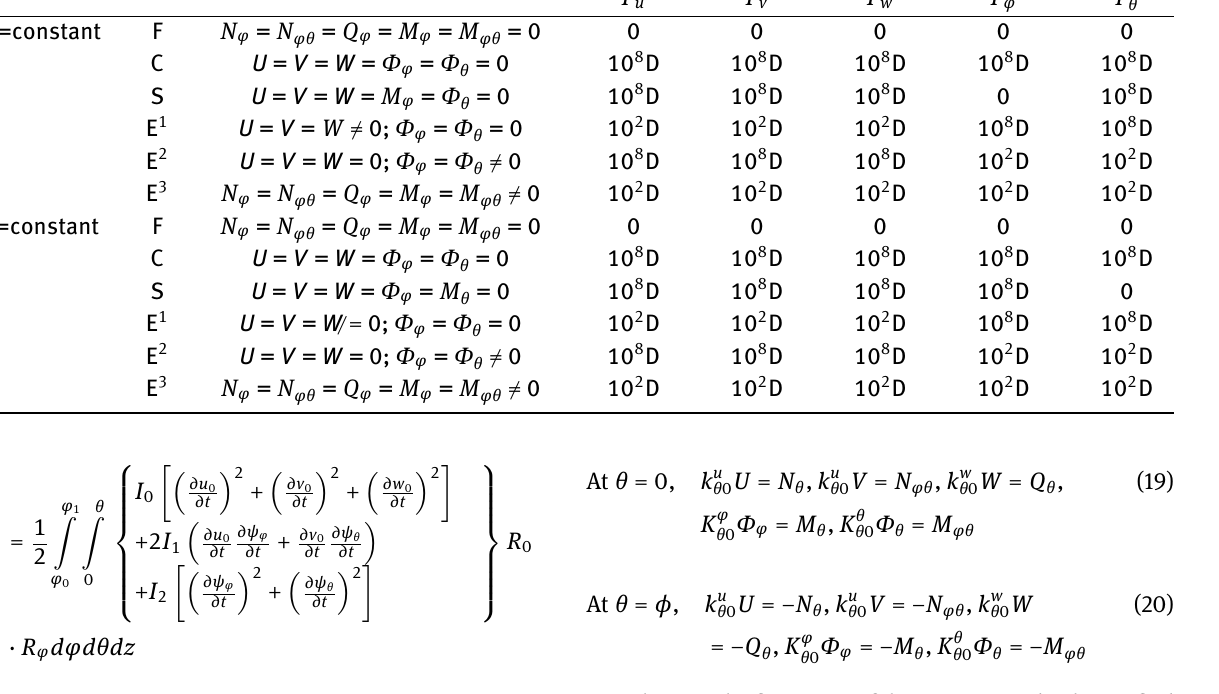
Table 1: The corresponding spring stiffness values for general boundary conditions. Edges BC Essential conditions